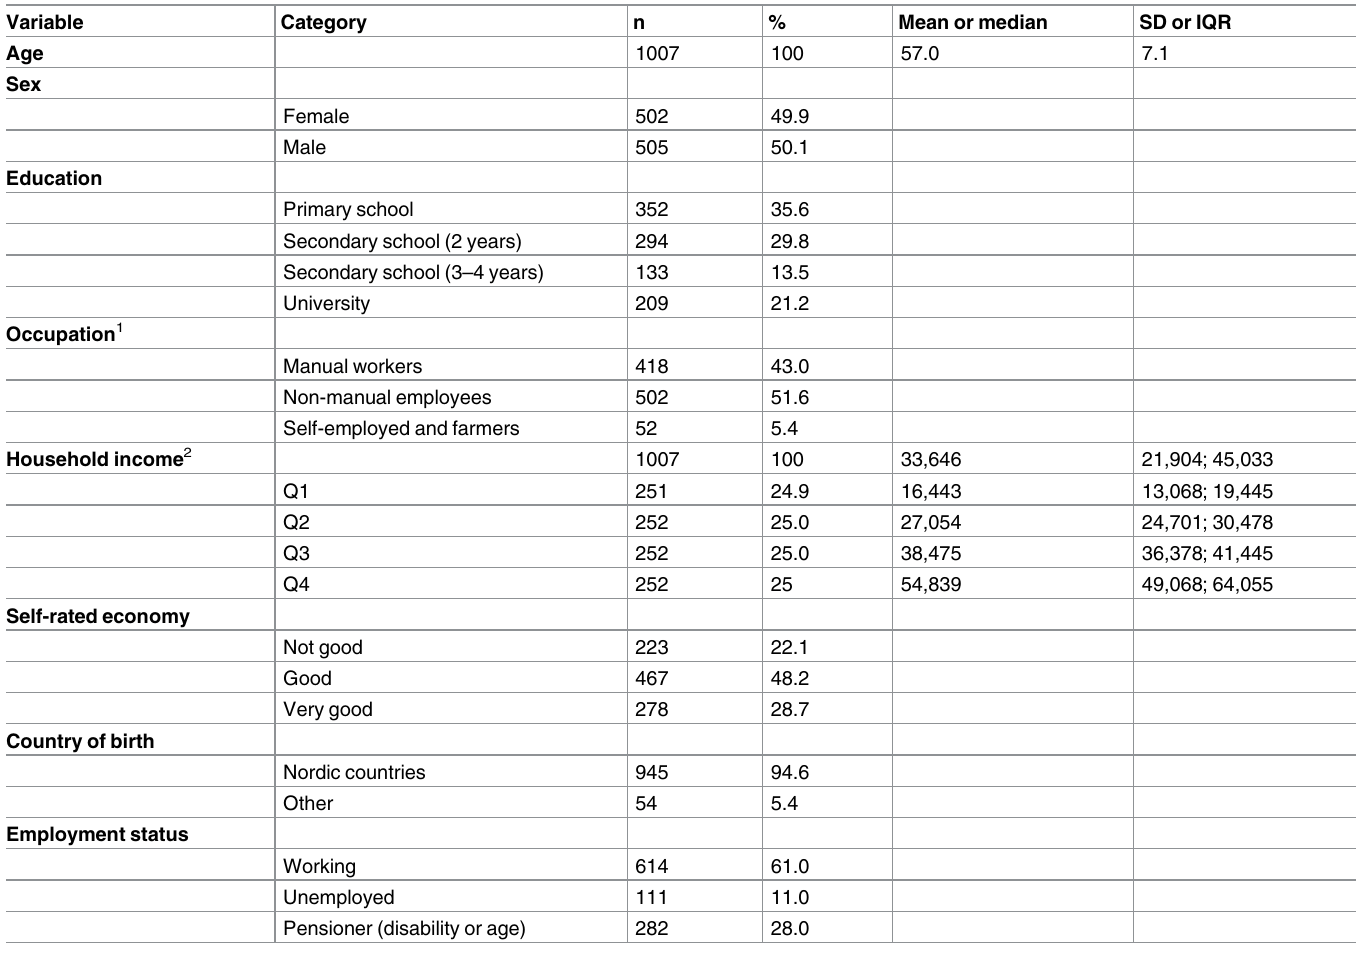
Table 1. Background and socioeconomic characteristics (n =